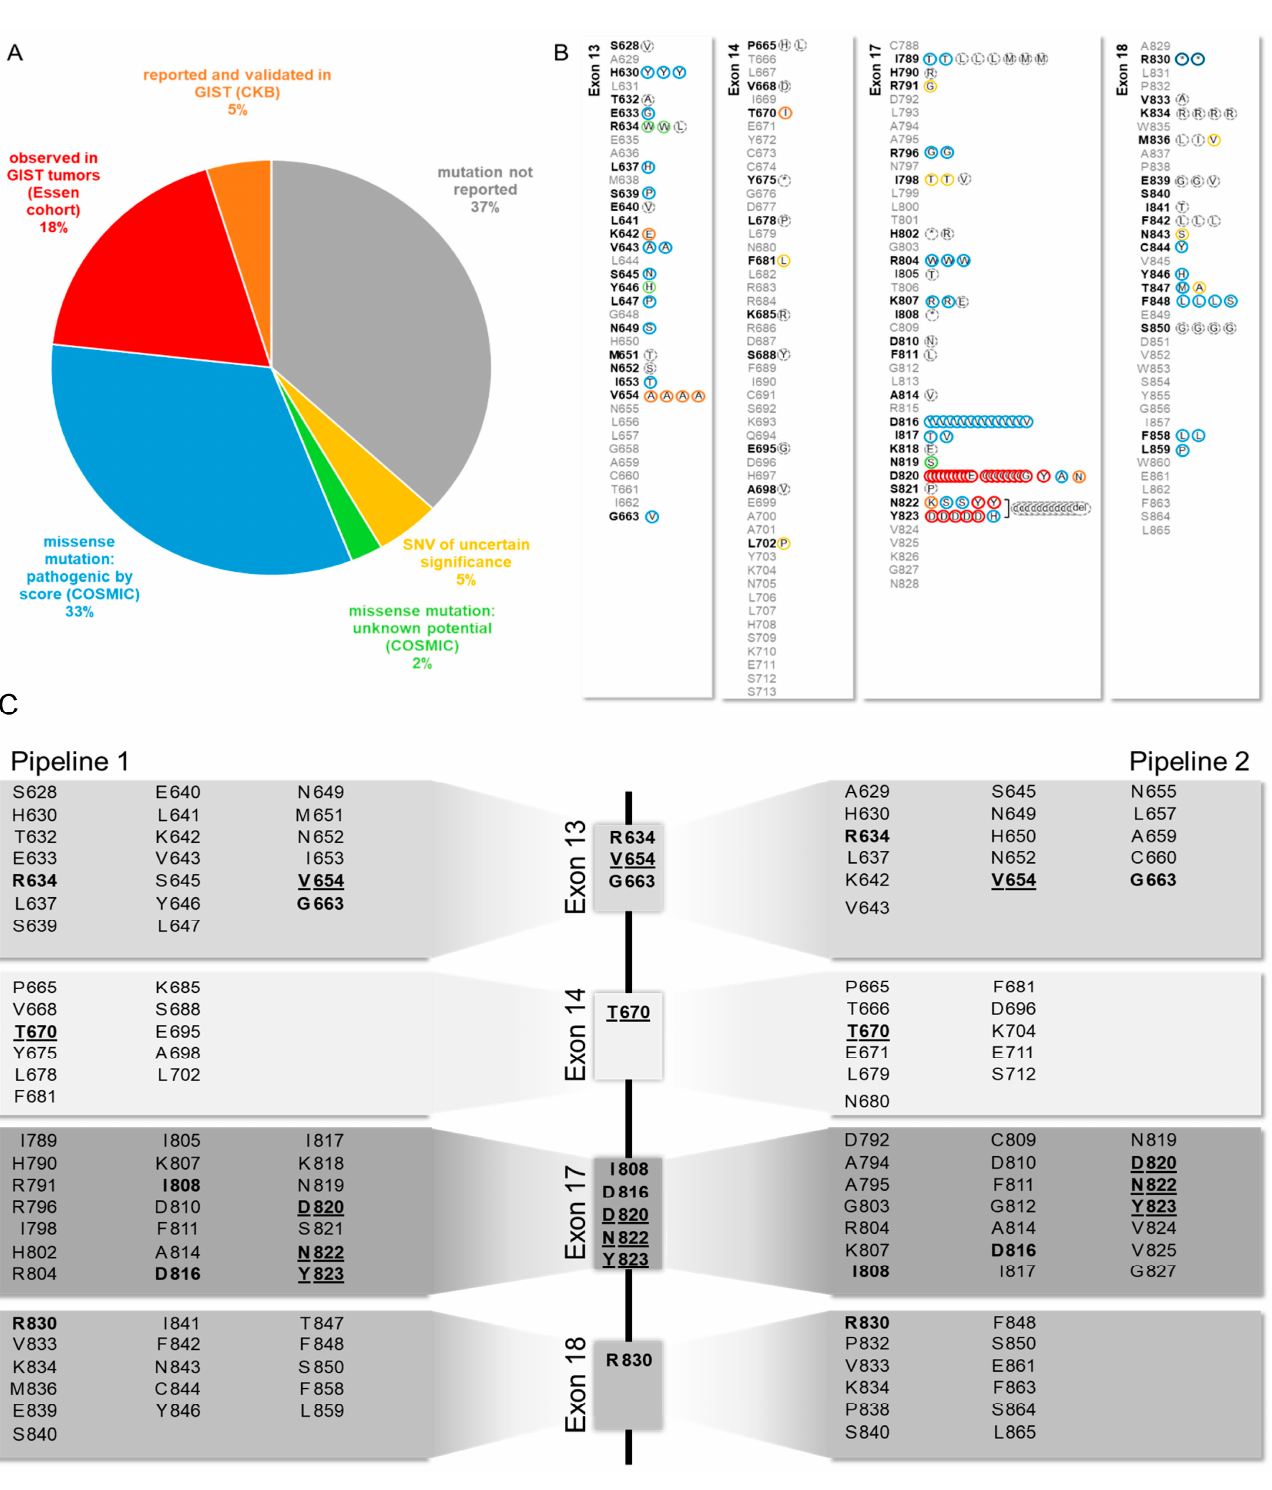
Figure 4. Distribution of KIT Mutations in exons 13, 14, 17, 18 found in patient plasma samples and clinical significance. ( A ) Distribution of clinical significance by manual database search. ( B ) Distribution of KIT mutations found by Pipeline 1, color code adopted from ( A ) Del: deletion, stop codon. ( C ) Analysis of sequencing data using two different pipelines. Pipeline 1: routine pathology pipeline; Pipeline 2: research pipeline. Mutations found by both pipelines displayed in the middle. Bold: found by both pipelines, underlined: Loci for known GIST resistance mutations.